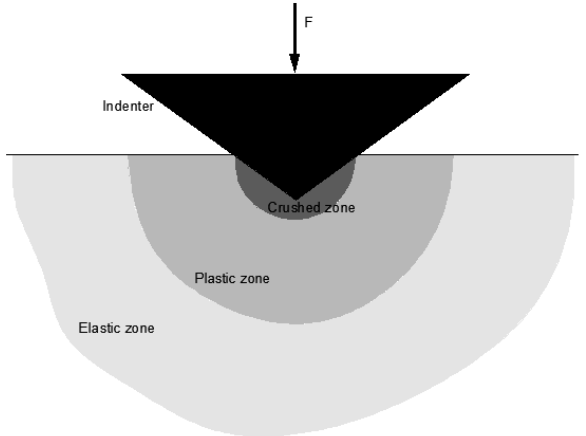
Figure 1. Zones formed by the impact of a pick on the rock.